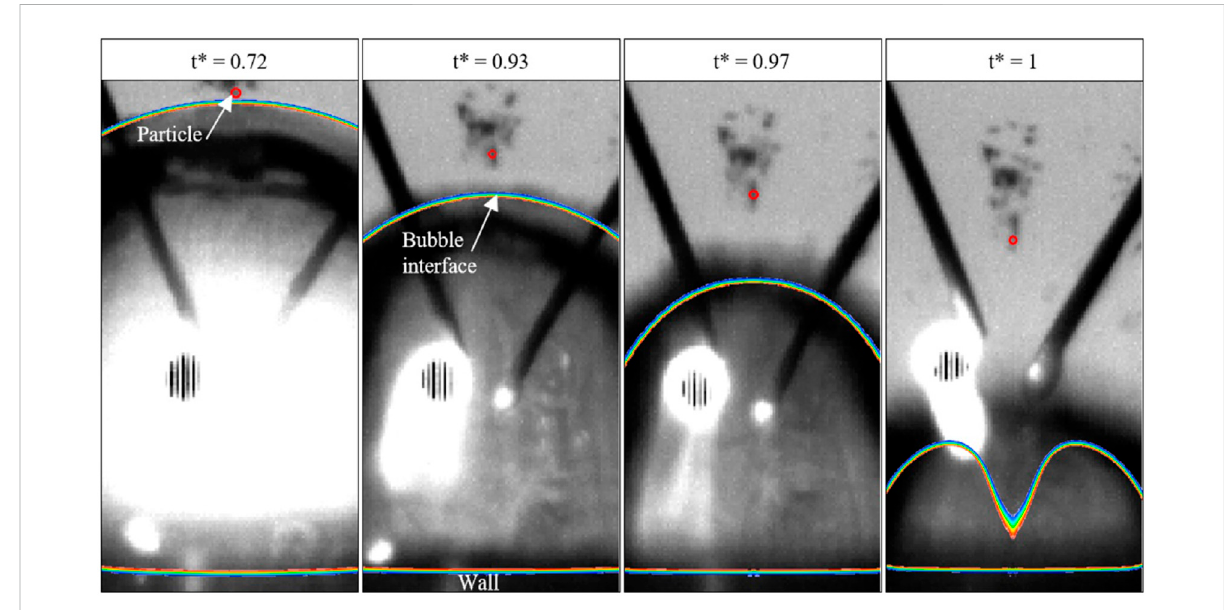
FIGURE 12 Comparison of experimentally observed and numerically predicted time evolution of bubble radius and nearby particle motions (Teran et al.,